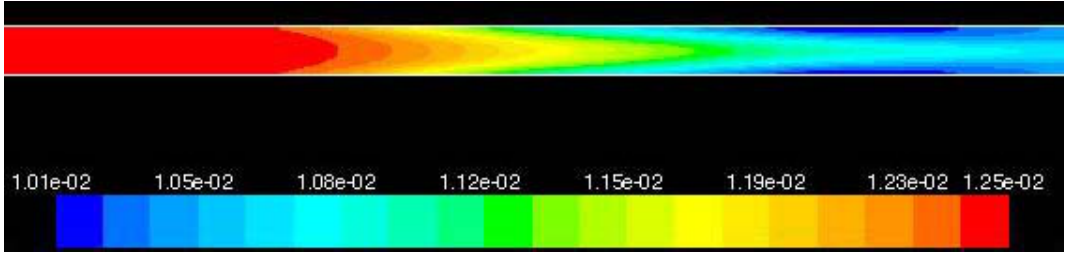
H at 900 °C and 20 mbar partial pressure of acetylene. 2 2